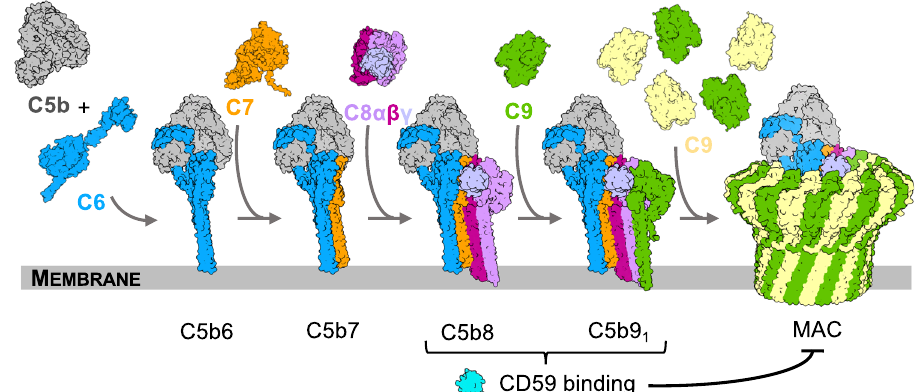
Fig.1|SchematicofMACassembly. TheMACporeisformedfromthesequential and stepwise assembly of complement proteins: C5b, grey; C6, blue; C7, orange; C8 α , pink; C8 β , magenta; C8 γ , light purple; C9, alternating monomers are yellow andgreen.Duringassembly,complementproteinsundergodramaticstructuralre- arrangementsinwhichtwohelicalbundleswithintheirMACPFdomainsunfurlinto membrane-inserting β -hairpins. CD59 (cyan) binds at two stages of this assembly